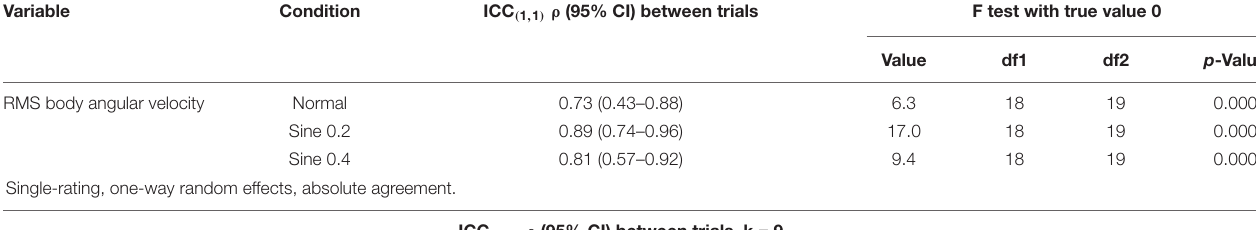
TABLE 2 | Intraclass Correlation Coefficient (ICC) results. Variable